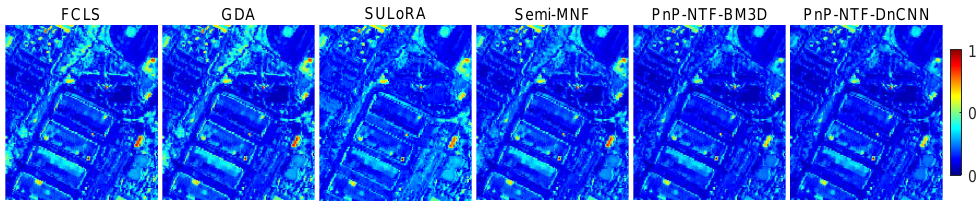
Figure 11. Estimated abundance maps comparison between the proposed algorithm and state-of-the-art algorithms on the San Diego Airport.